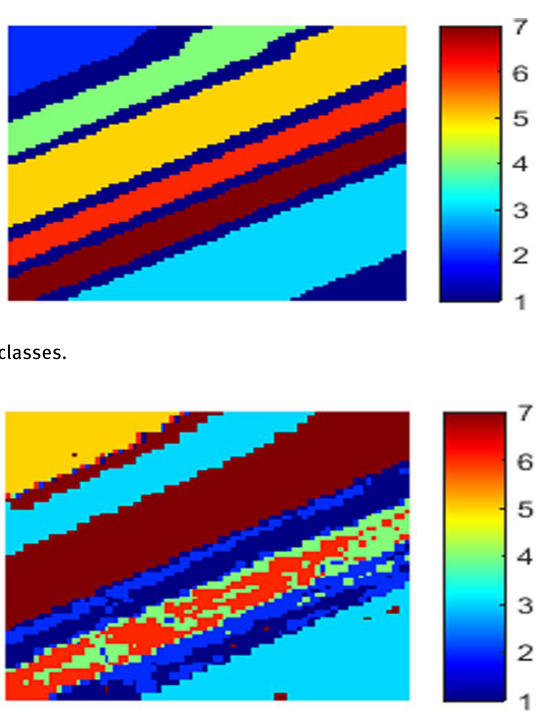
Figure 9: Salinas A solutions obtained by FCM